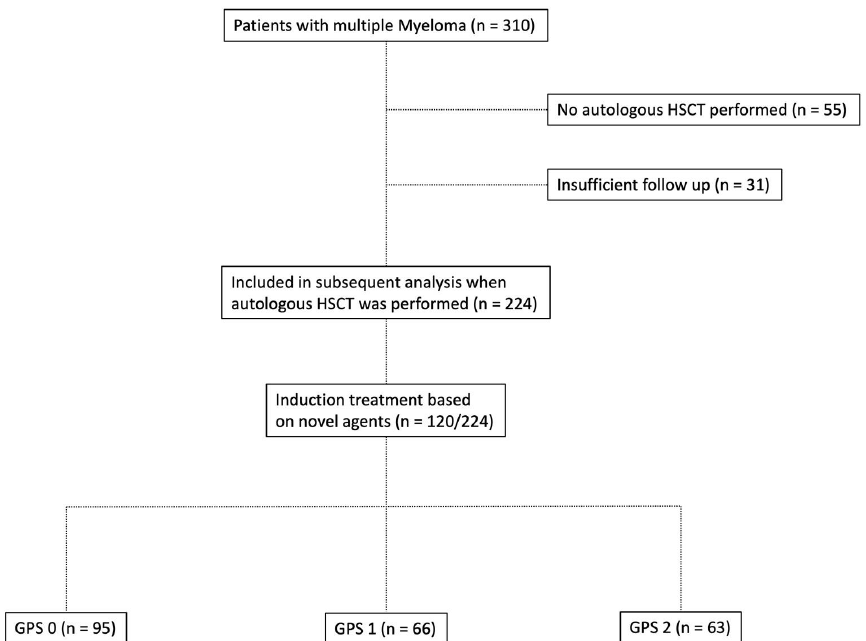
Figure 1. Flowchart depicting the composition of patients with multiple myeloma who underwent autologous hematopoietic stem cell transplantation (HSCT) in the study group.